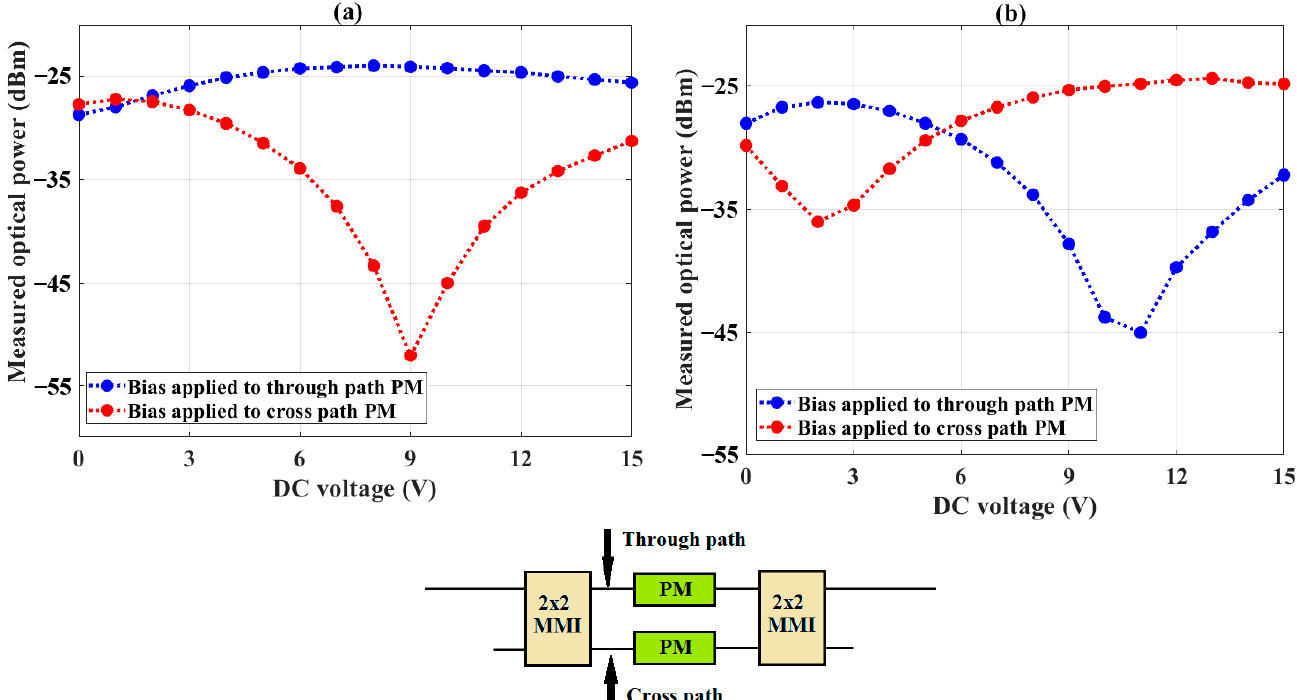
Figure 6. DC characteristics of ( a ) MZM a and ( b ) MZM b in terms of output optical power due to the variation of DC bias voltage. Input port one and two are considered for light input to MZM a and MZM b , respectively. Output is taken from output port three for both cases. Each MZM is asymmetrically driven which means DC voltage is applied to only one arm of the corresponding MZM. PM, phase modulator .